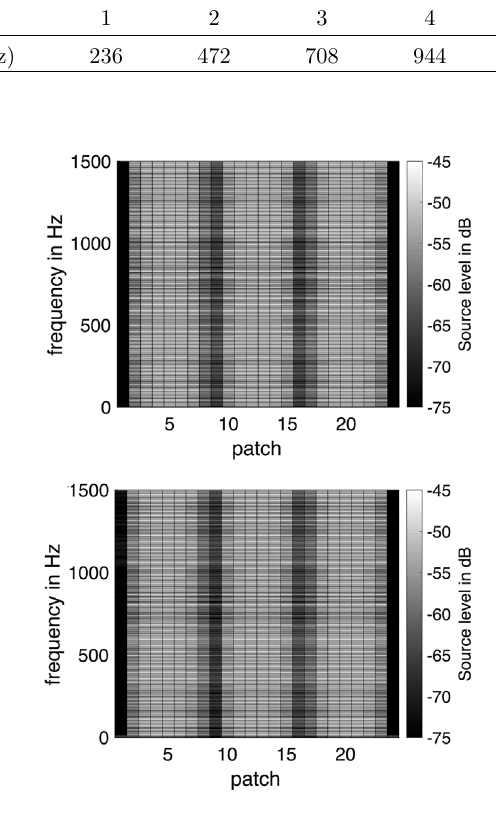
Figure 17. Comparison of the original source distribution along the 24 patches (upper) and the reconstructed source distribution (lower) as function of frequency for N p = 3. Reconstruction based on near- fi eld receiving positions.